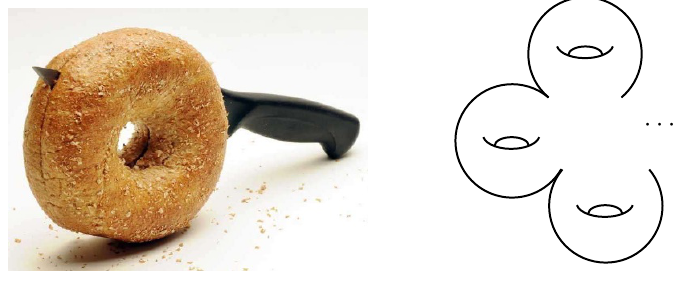
Figure 3 . Left: bipartition of the thermal AdS 3 . Right: the glued 3-manifold is a (cid:13)at bouquet-like n